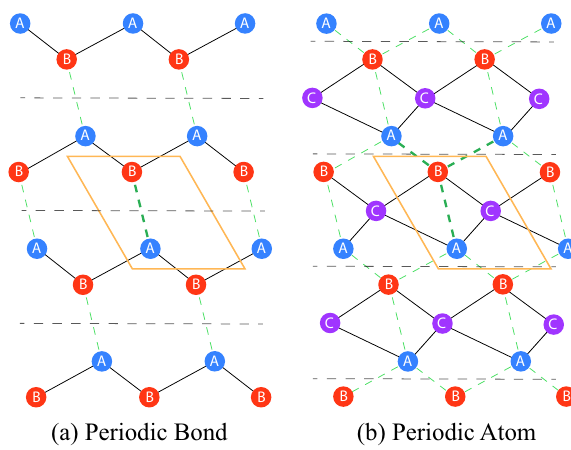
Fig. 2 Representation of the bond cleaving algorithm. a The periodic bond approach cleaves all periodic images of a bond. b The periodic atom approach cleaves the bonds between all periodic images of the atoms. The periodic atom approach requires at least three atoms in the primitive cell to generate a cleaved